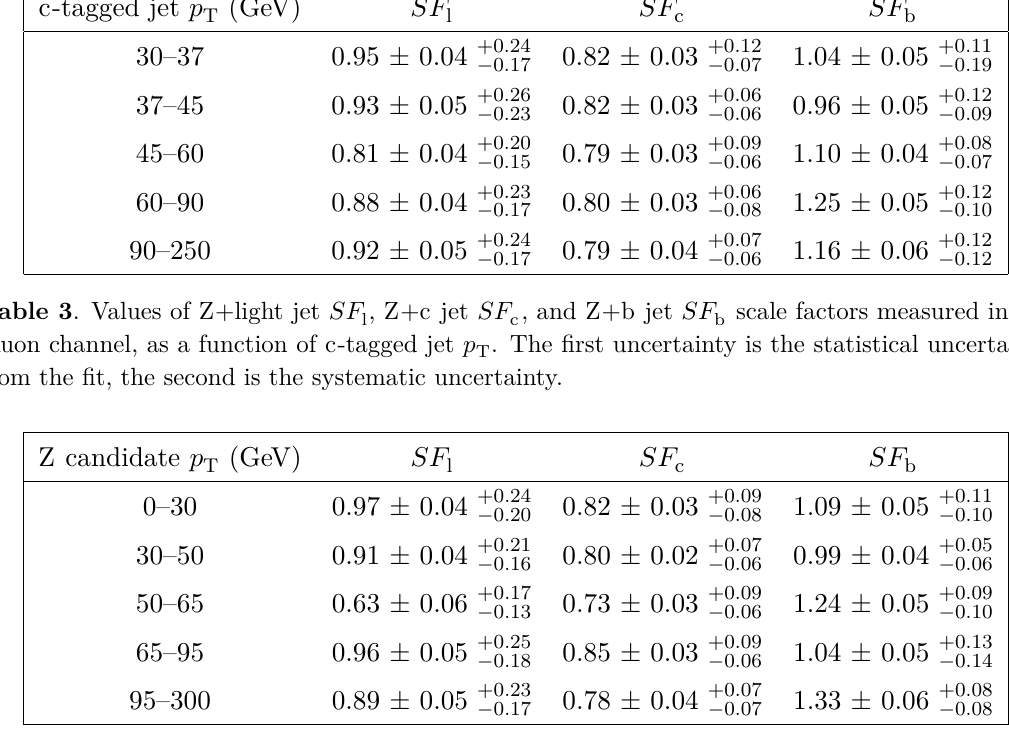
Table 4 . Values of Z +light jet SF muon channel, as a function of Z candidate p from the fit, the second is the systematic